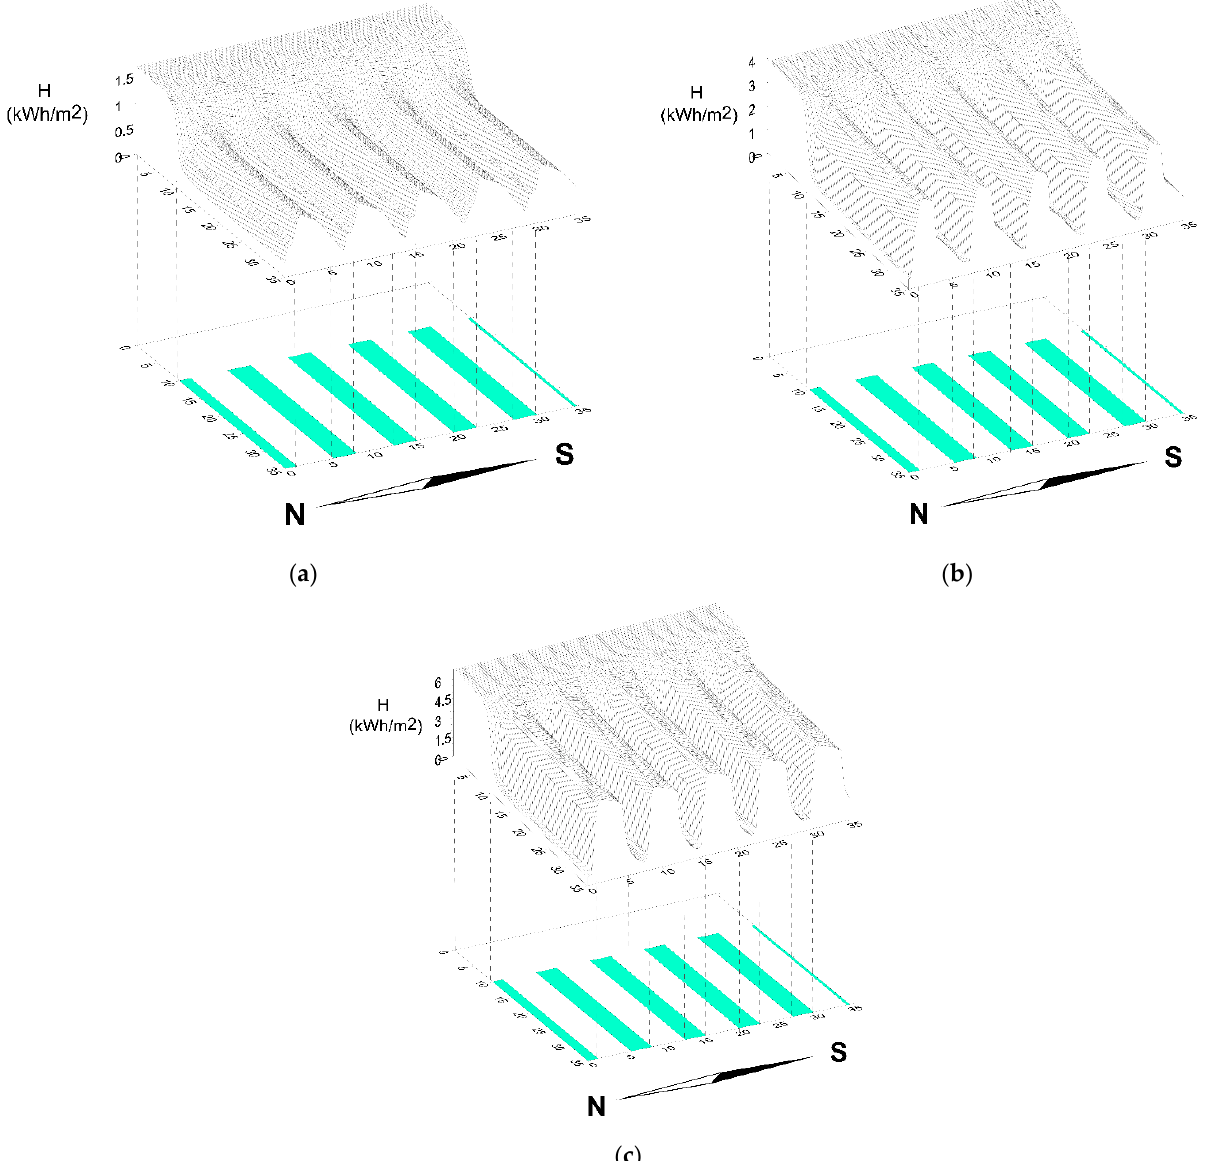
Figure 8. Representation of solar radiation at the “Alcolea 1” installation by means of contour lines and three-dimensional representation on a synoptic day of ( a ) December, ( b ) March, ( c ) June.